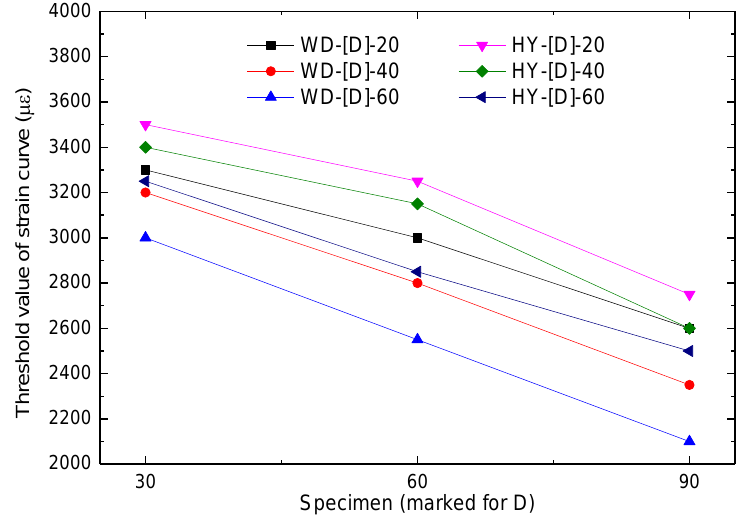
Figure 10. Threshold values of strain curves.